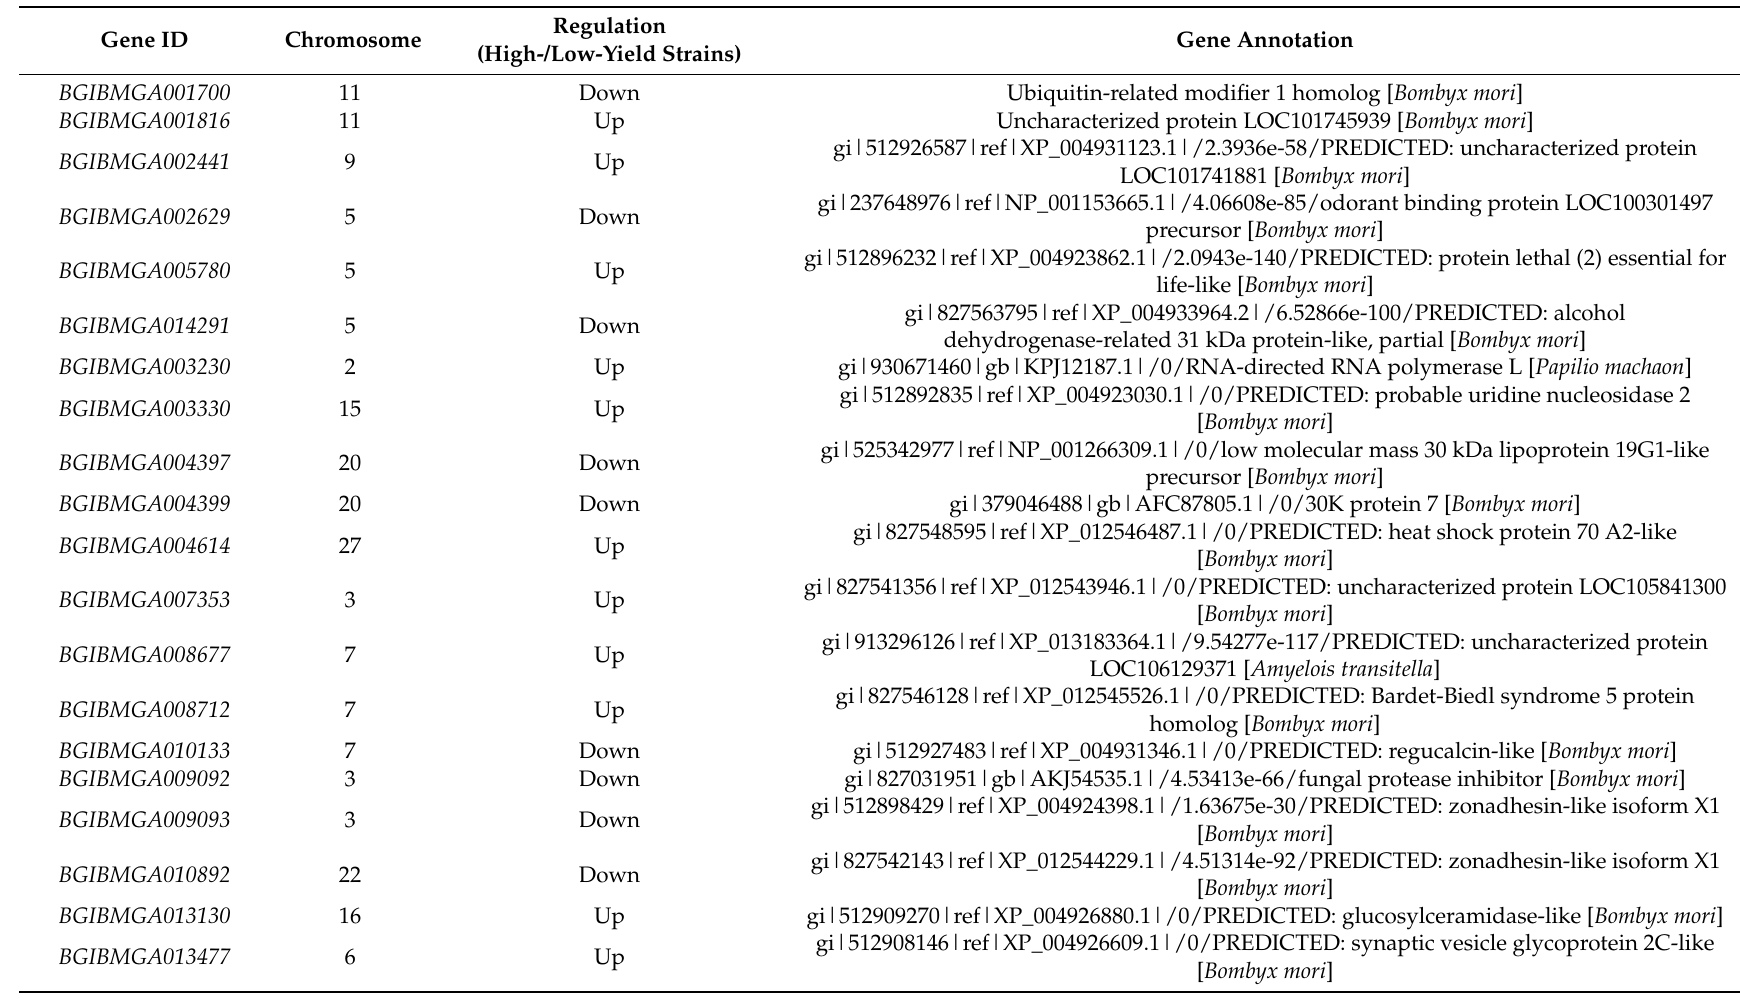
Table 4. Functional annotation of the common DEGs in high-yield vs. low-yield